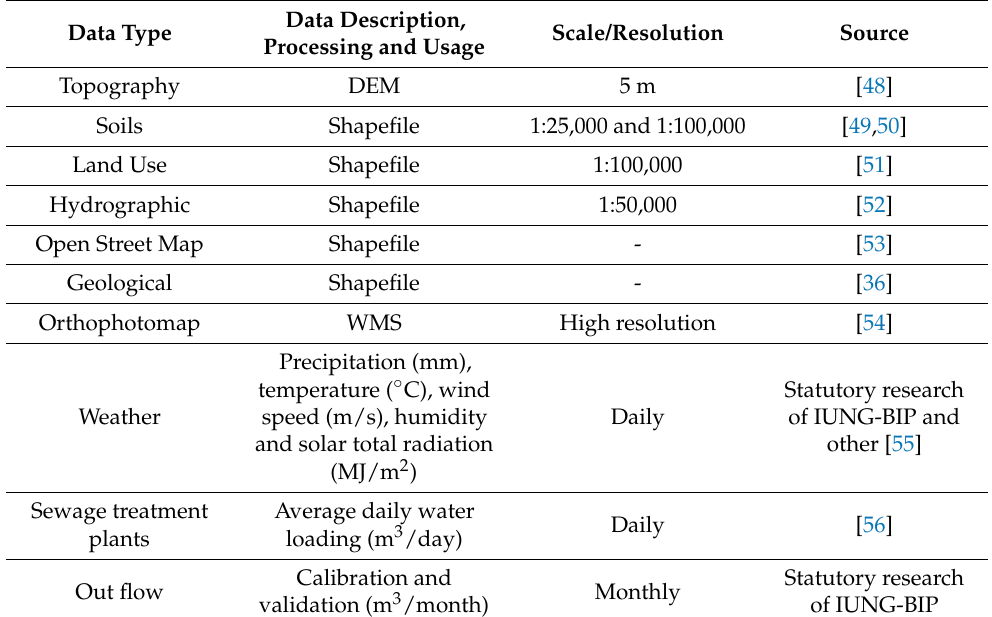
Table 1. Input data used in SWAT model and SUFI-2 algorithm